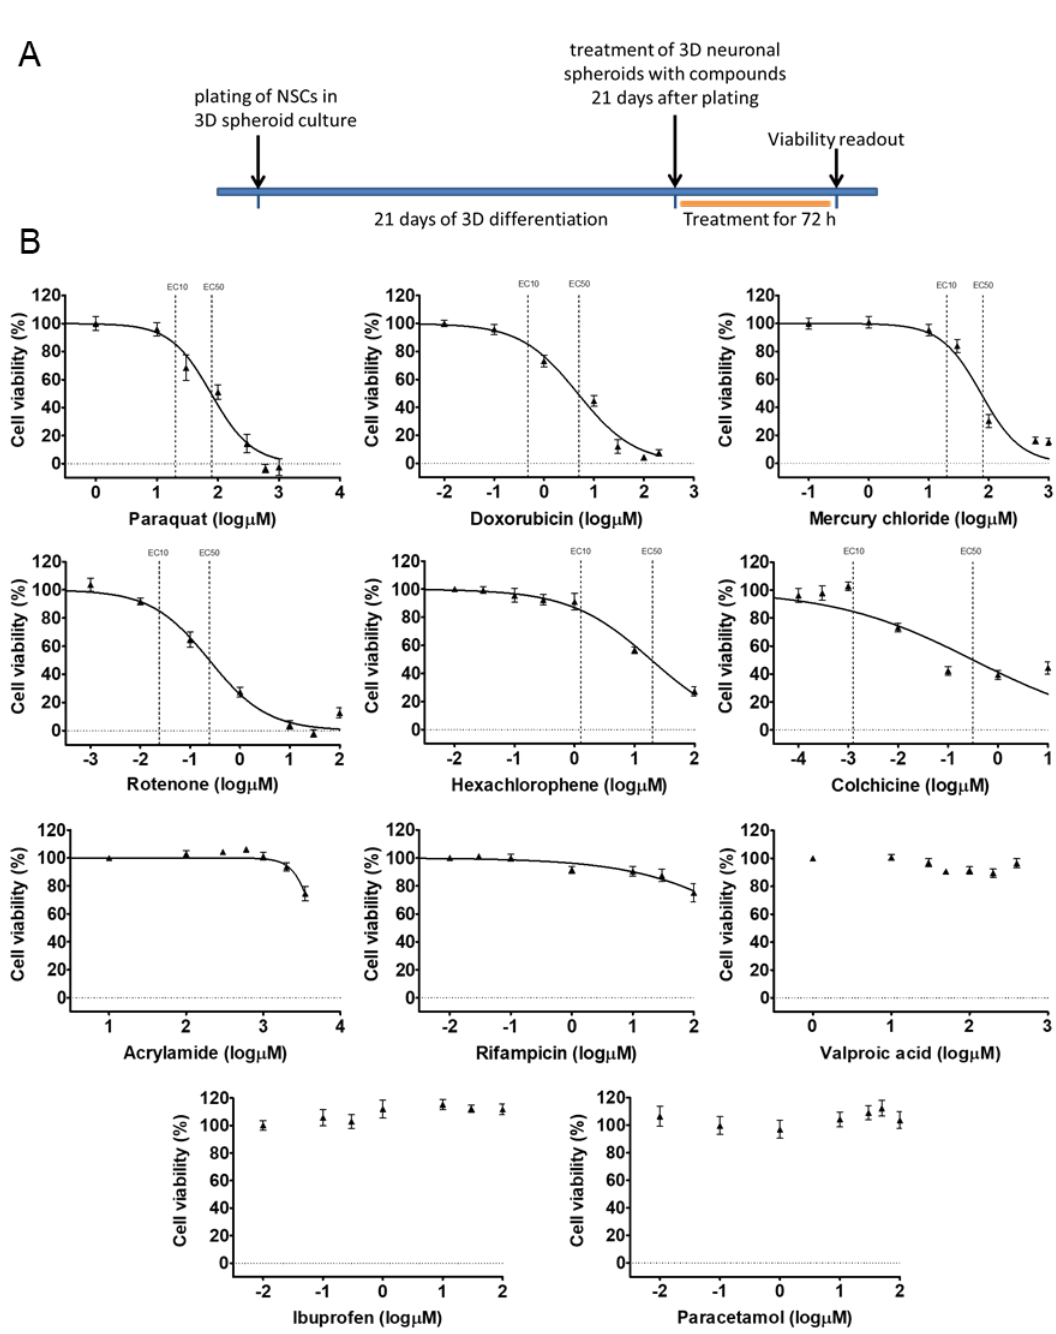
Figure 5. Cell viability measurement on D21 3D neurospheres after 72 h exposure. ( A ) Exposure scheme at D21 stage. ( B ) Concentration response curves of compounds, tested in 7 different concentrations (see concentrations listed in Table S3), representing the cell viability (%) of treated D21 3D neurospheres ( n = 3). Concentration values are presented in log µM ± SEM. EC10 and EC50 values are presented on graphs where applicable.